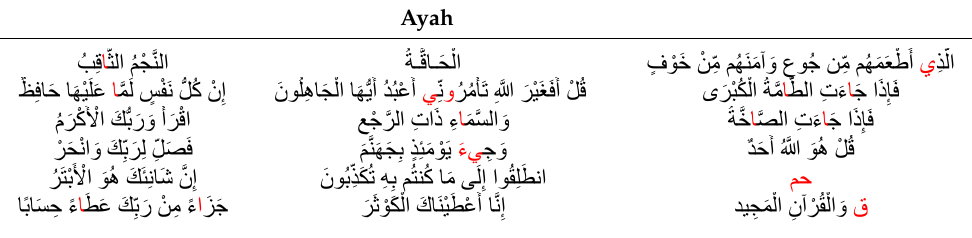
Table 2. The verses selected to the dataset.